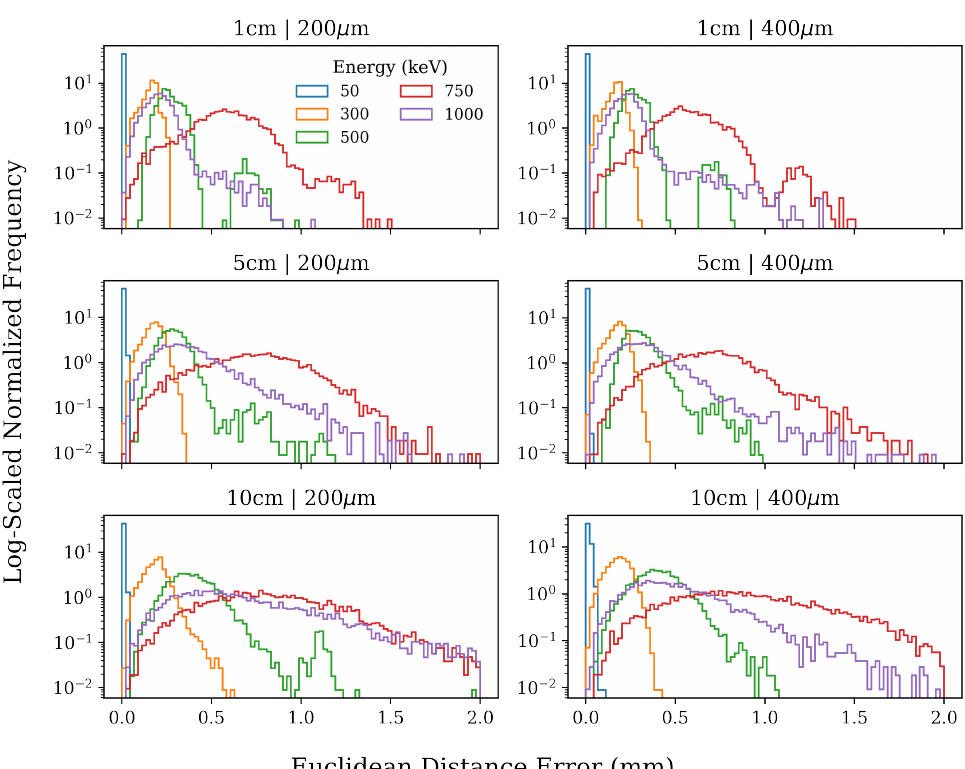
Figure 7. Euclidean distance error for the head models trained on data composed of all energies and drift distances at a particular pitch. The median after combining all energy distributions in the 200 µ m column is 0.20114, 0.24877 and 0.33071 mm for the 1, 5 and 10 cm drift distances, respectively. Likewise, the 400 µ m column gives median errors of 0.21661, 0.24439, and 0.31654